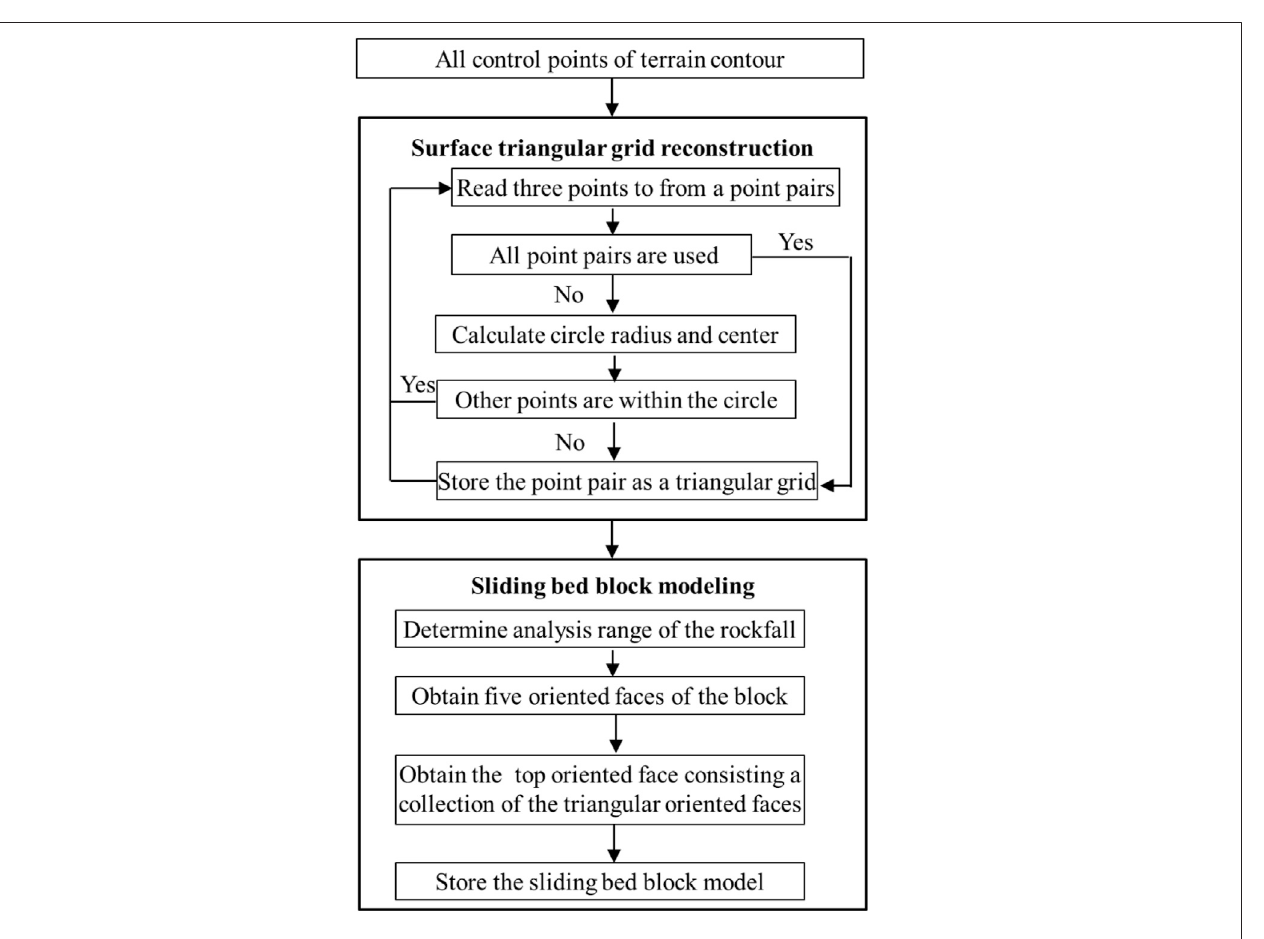
FIGURE 6 | Implementation of the sliding bed rock block